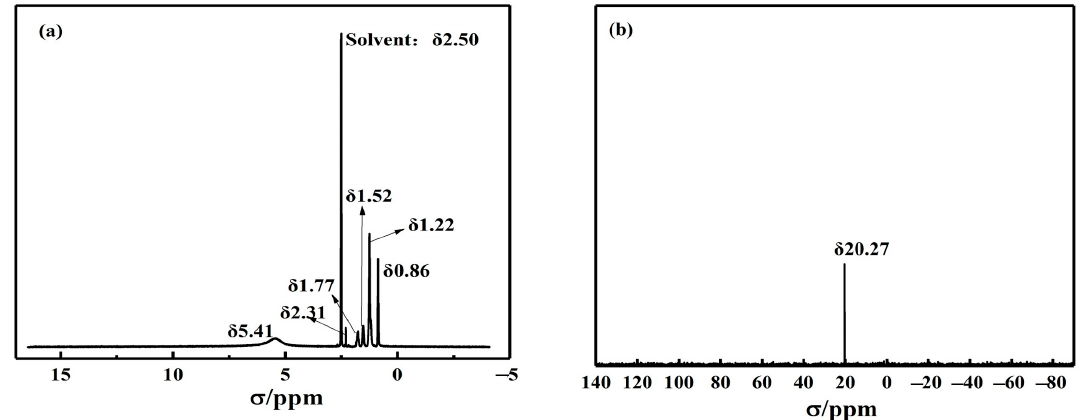
Minerals 2023 , 13 , x FOR PEER REVIEW 12 of 17